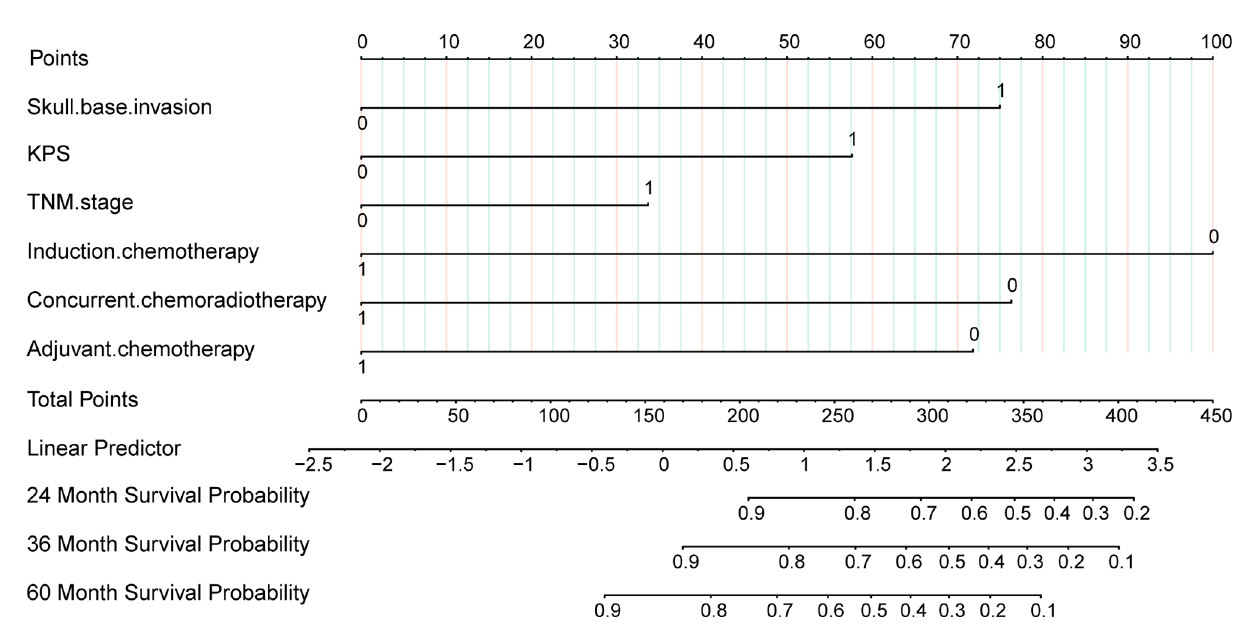
FIGURE 4 | Nomogram predicting 24, 36, and 60 months of bone metastasis-free